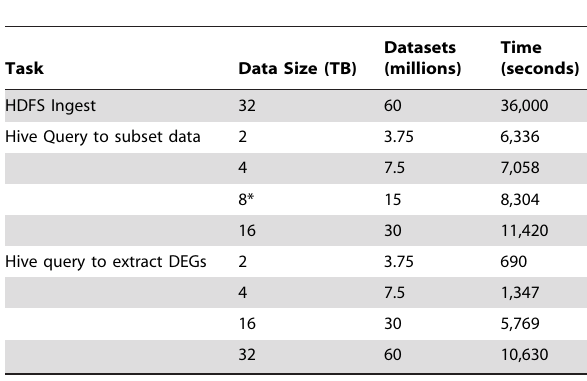
Table 1. Load and query times using simulated gene expression